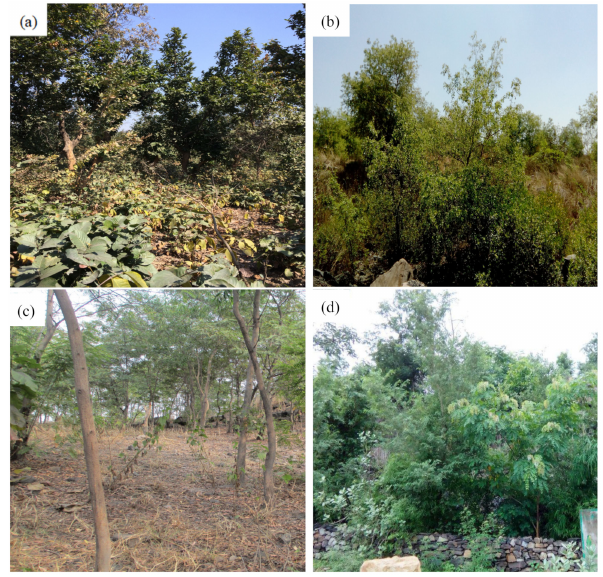
Figure2. Distanceviewofthestudysites: ( a )naturalforestshowingthedominanceof Shorearobusta trees and a ff orested mine land showing the growth of fast-growing trees ( b ) Dalbergia sissoo , ( c ) Albizia lebbeck , and ( d ) Albizia procera . Table 1. Vegetation characteristics and accumulation of biomass carbon in a natural forest and a ff orested trees. Tree